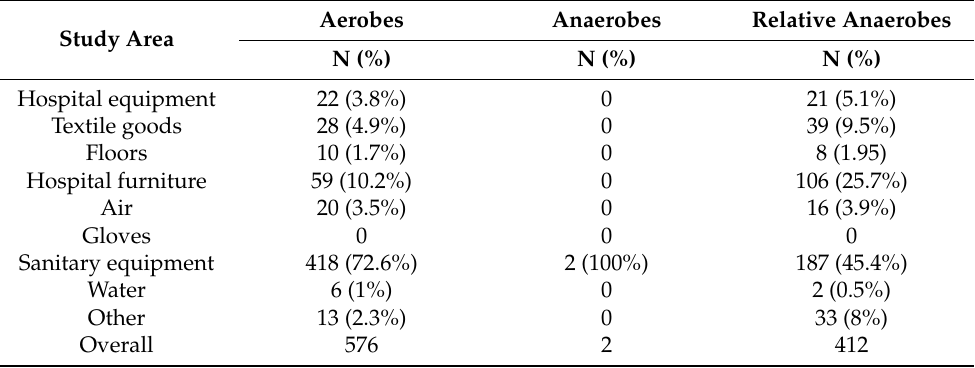
Table 4. Distribution of a sampling location category among areobes, anaerobes, and relative anaerobes 1